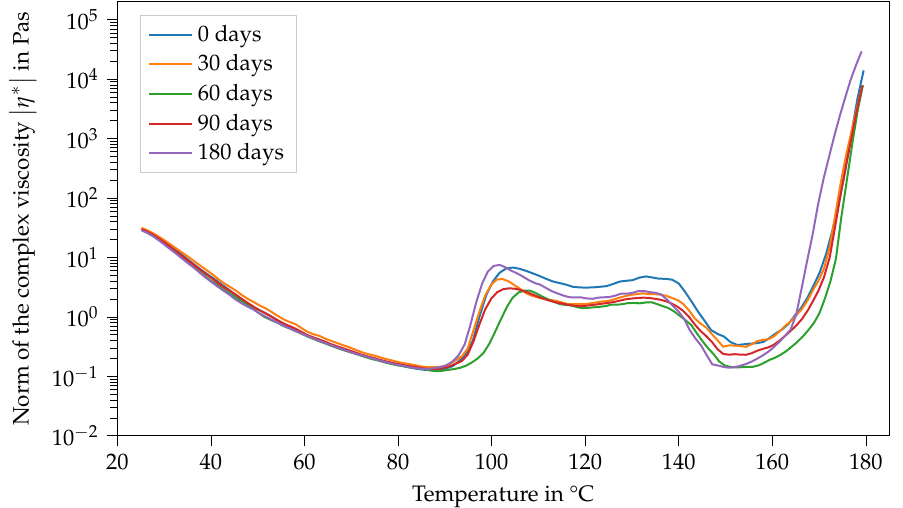
Figure 7. Norm of the complex viscosity of Argopox-1 between 25°C and 180°C after storage periods of 0d, 30d, 60d, 90d and 180d at T = −